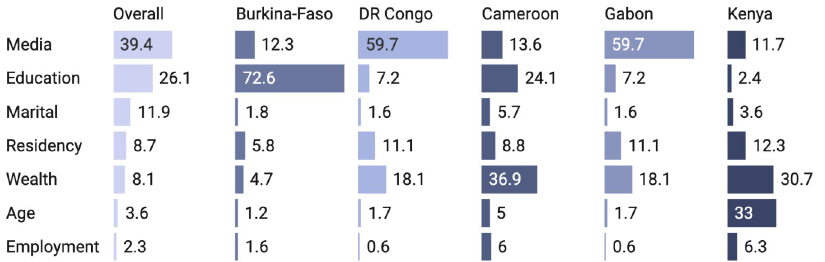
Fig 4. Relative importance of the variables in the